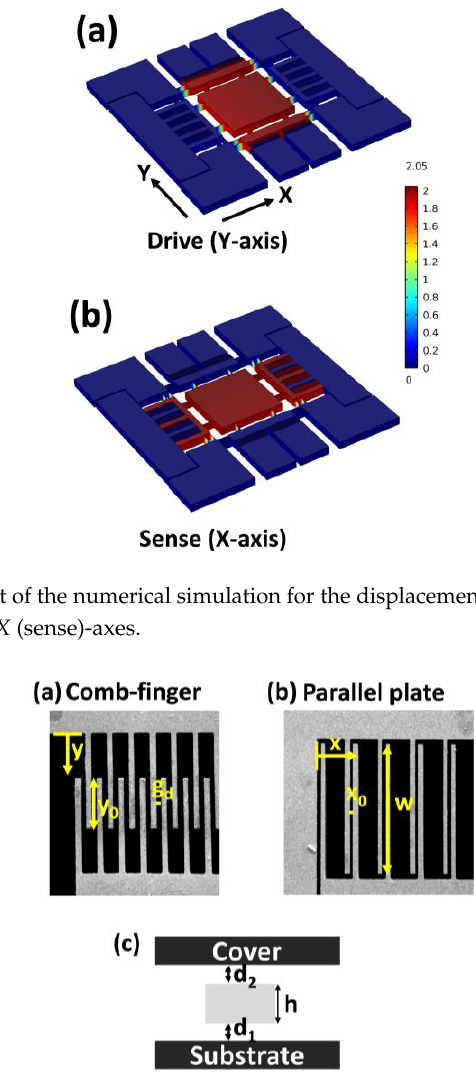
Figure 4. Dimensions of the gyroscope. ( a ) Part of the comb finger: y shows the position along the Y -axis, y 0 represents the overlapped length of the electrodes, and g d is the gap between electrodes. ( b ) Part of the parallel plate: x shows the position along the X -axis, x 0 represents the gap between electrodes, and w represents the overlapped length of the electrodes. ( c ) Cross-sectional view: h represents the device thickness and d 1 and d 2 are the gaps between the device and substrate or cover.